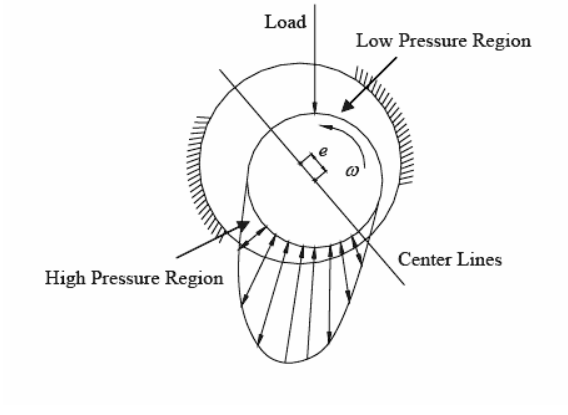
Fig. 1. Pressure field generated in a plain journal